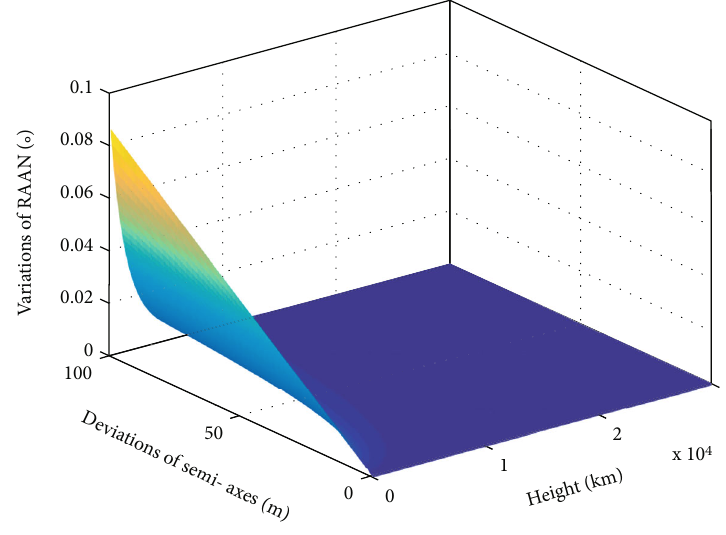
Figure 1: Variations of RANN.